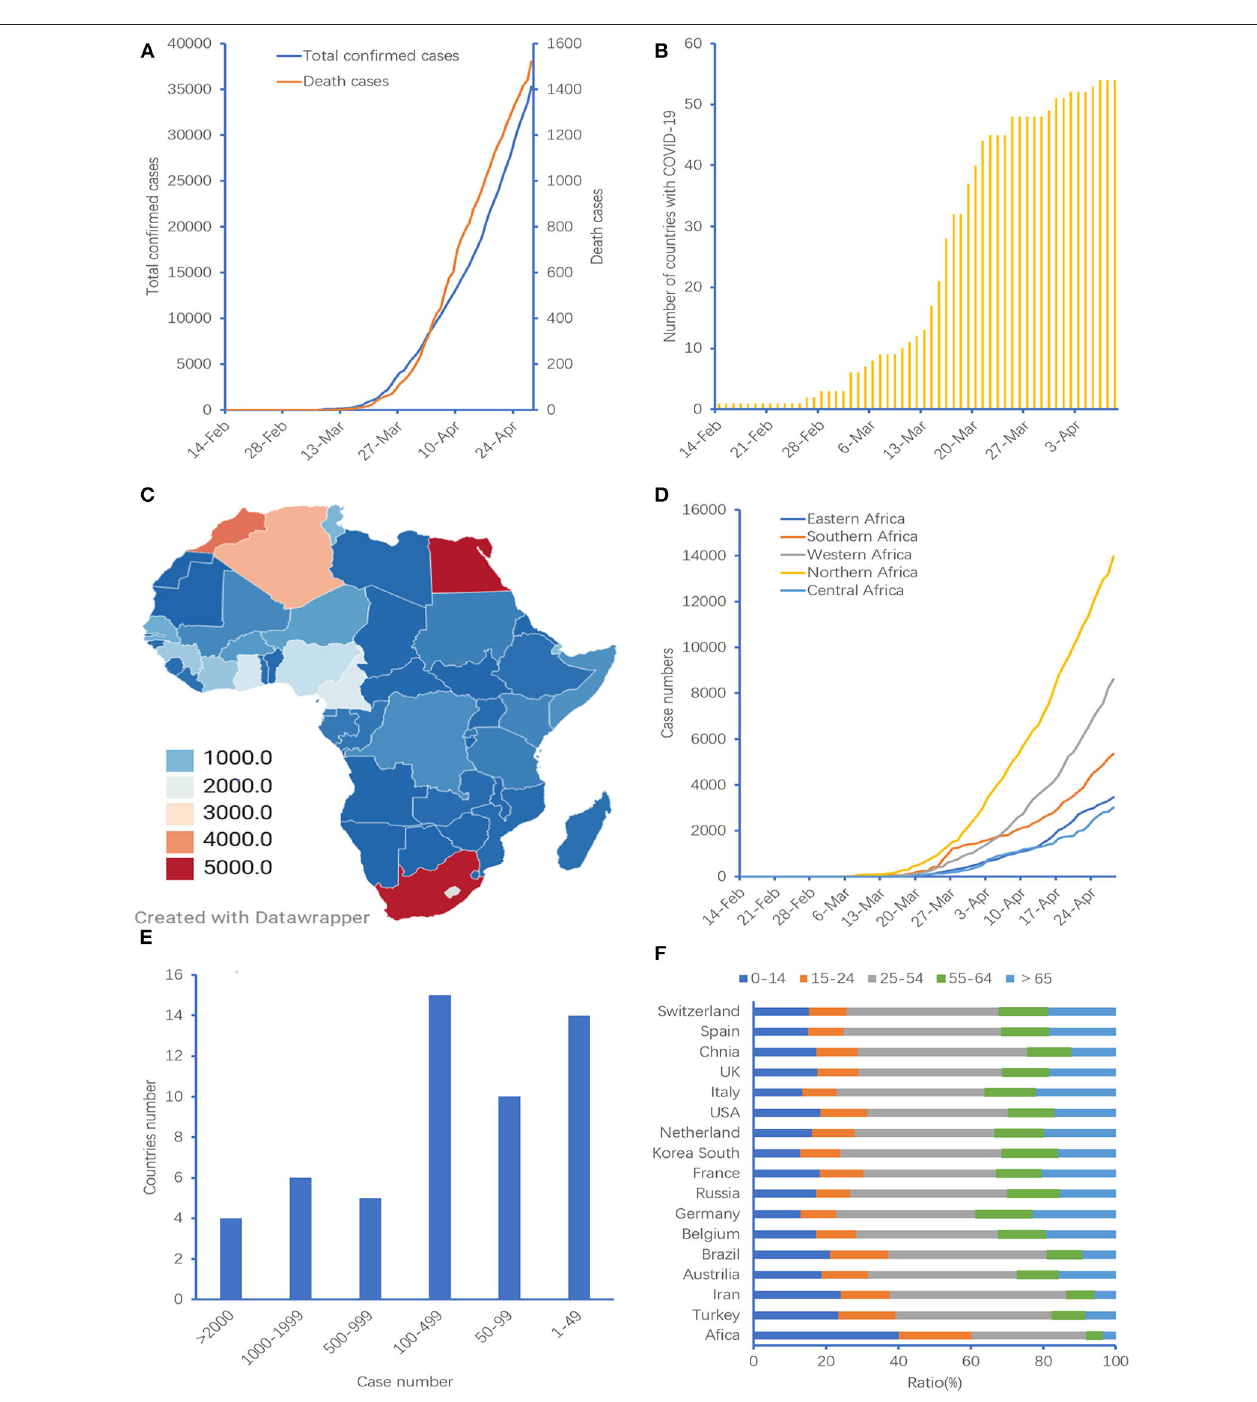
FIGURE 2 | Case number and distribution in Africa. (A) Confirmed COVID-19 and death cases in Africa over time, (B) number of countries with COVID-19 over time, (C) case distribution in Africa, (D) confirmed COVID-19 cases in different African regions. Three countries of Sahrawi Arab Democratic Republic (Northern Africa), Union of the Comoros (Eastern Africa), and Kingdom of Lesotho (Southern Africa) are not included, (E) distribution of COVID-19 cases in different countries in Africa, (F) age structure in Africa and other countries. Two countries of Mayotte and Reunion are not included.